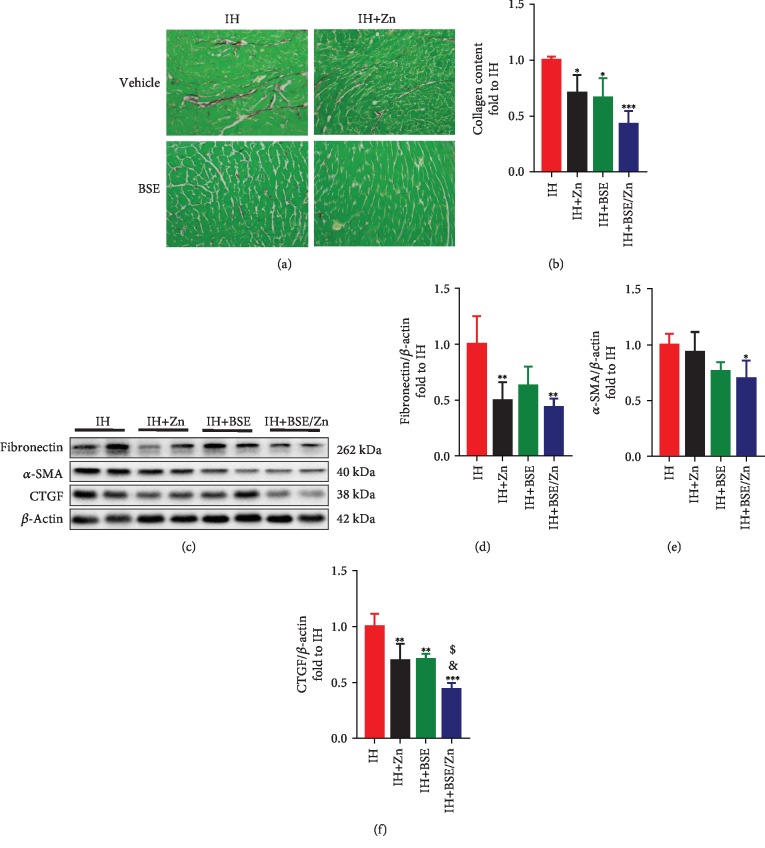
BSE and/or Zn treatment ameliorates cardiac fibrosis. (a, b) Cardiac collagen deposition was assessed by Sirius Red staining. (c–f) Cardiac fibrosis was assessed by western blotting analyses of fibronectin, α-SMA, and CTGF. Data are presented as the means ± SD (n = 4). ∗P < 0.05vs. IH group mice; ∗∗P < 0.01vs. IH group mice; ∗∗∗P < 0.001vs. IH group mice; &P < 0.05vs. IH+Zn group mice; $P < 0.05vs. IH+BSE group mice.